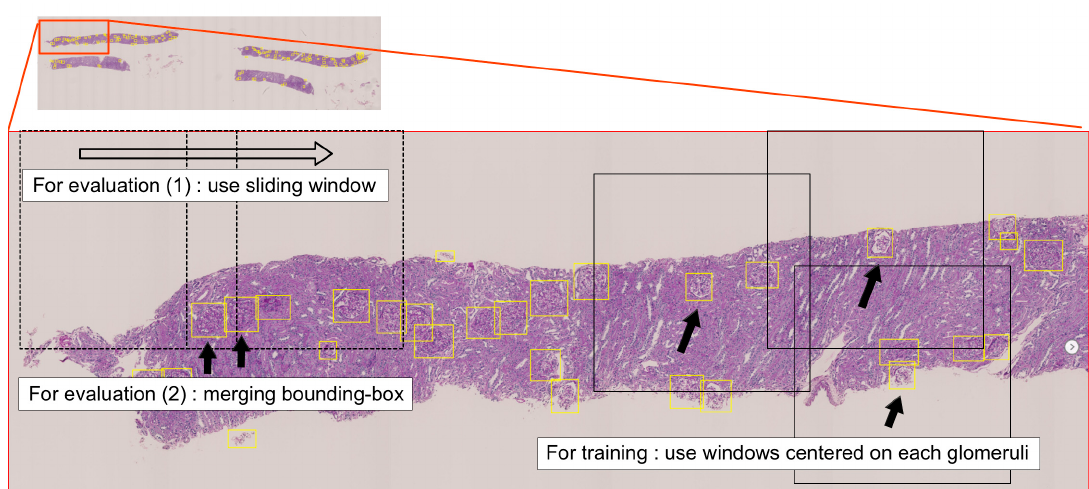
Figure 2. Overview of the glomerular detection process. Yellow frames indicate bounding boxes around glomerular regions (ground truths). The size of the window presented as a black frame is 1099 × 1099 pixels (2000 × 2000 μ m). For training the network, images cropped by the windows centered on each annotated glomerulus were used. For evaluating the network, images scanned by a sliding window were used. After detection of glomeruli in all images, overlapping bounding boxes located at the boundaries of the windows were merged to avoid duplicate detection.